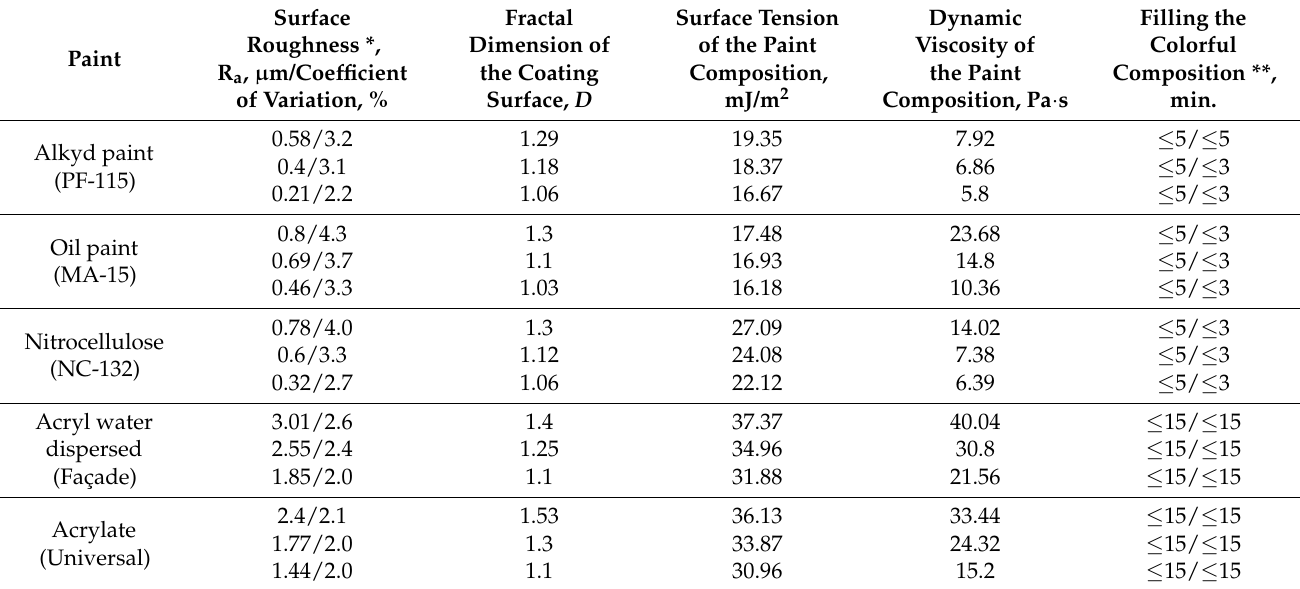
Table 3. Effect of rheological properties of paints on the coatings appearance